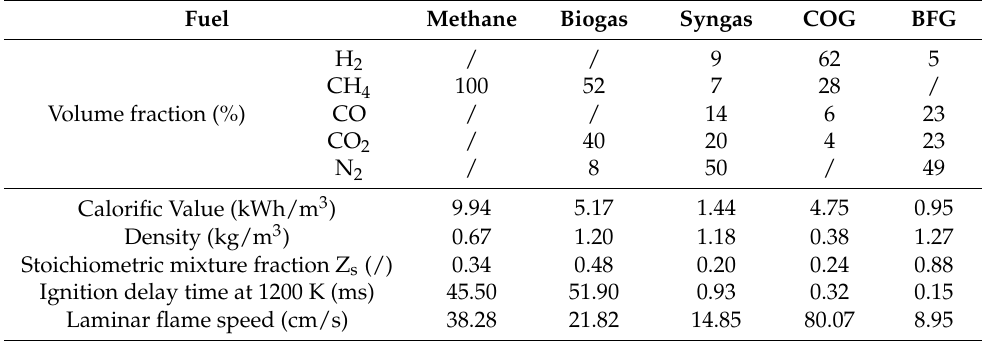
Table 1. Typical compositions and key characteristics of LCIG compared with methane.